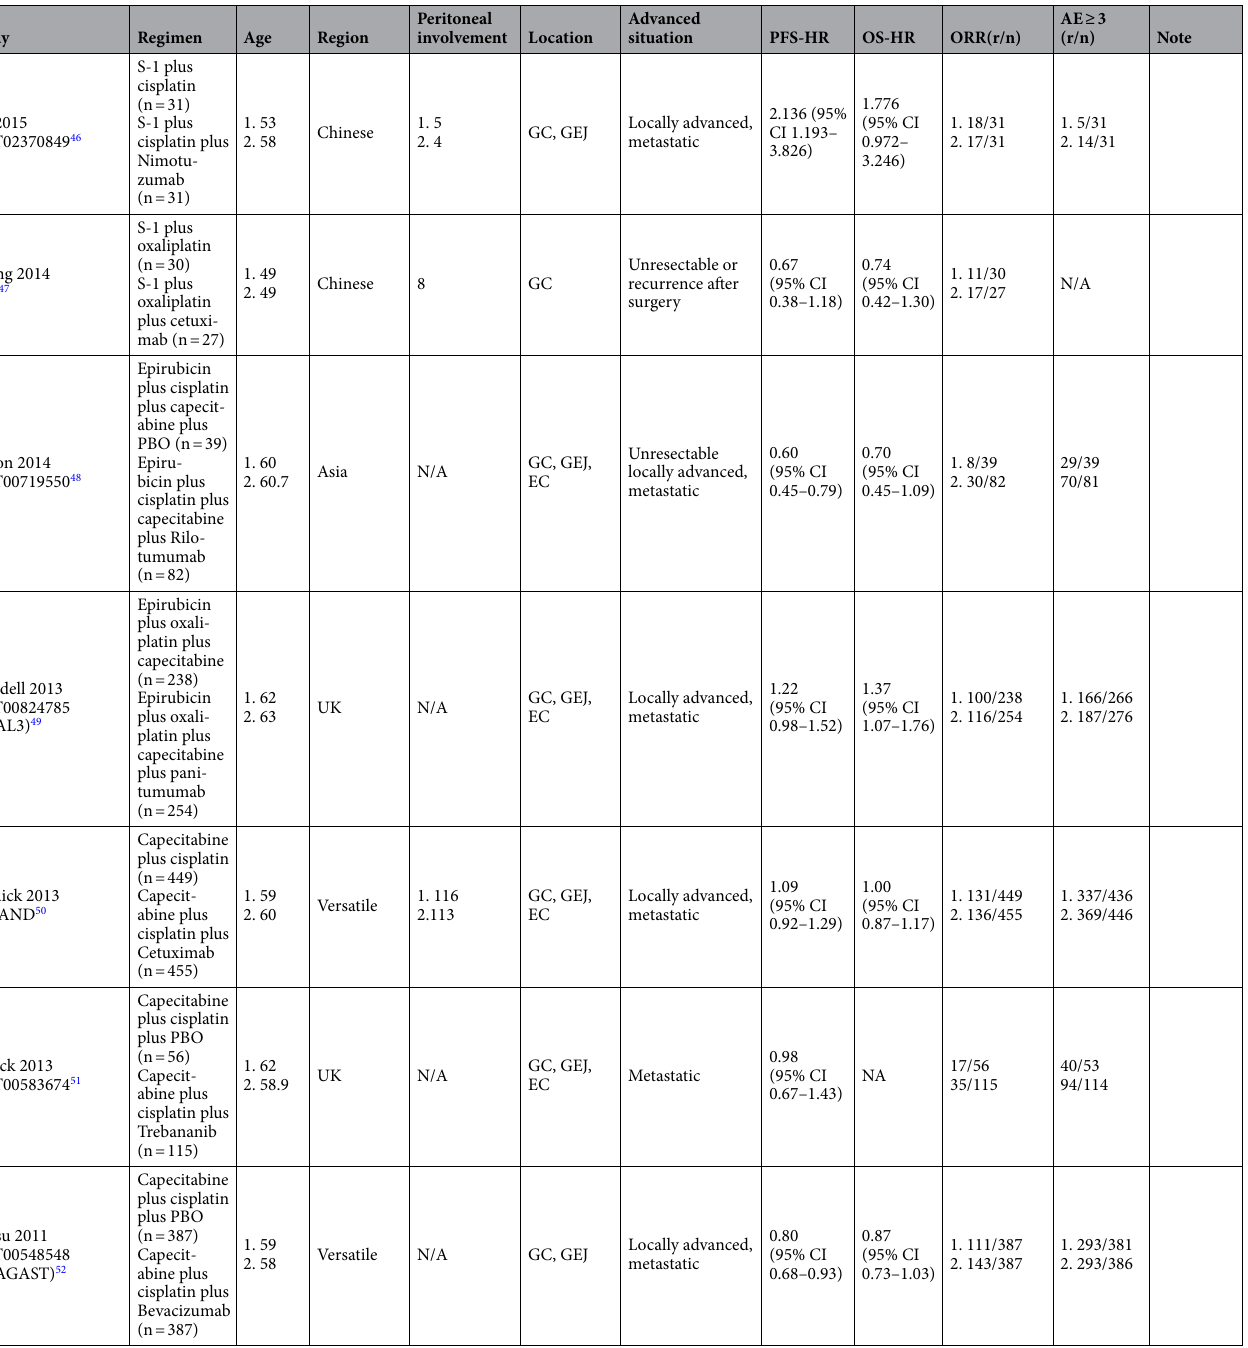
Table 1. Baseline characteristics of eligible studies in average group. GC gastric cancer, GEJ gastroesophageal junction cancer, EC esophageal